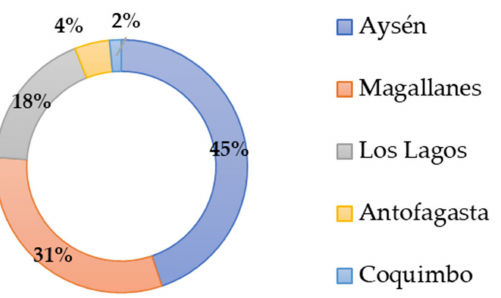
Figure 7. Distribution of Alexandrium HABs events from 1972 to 2020 in Chile.